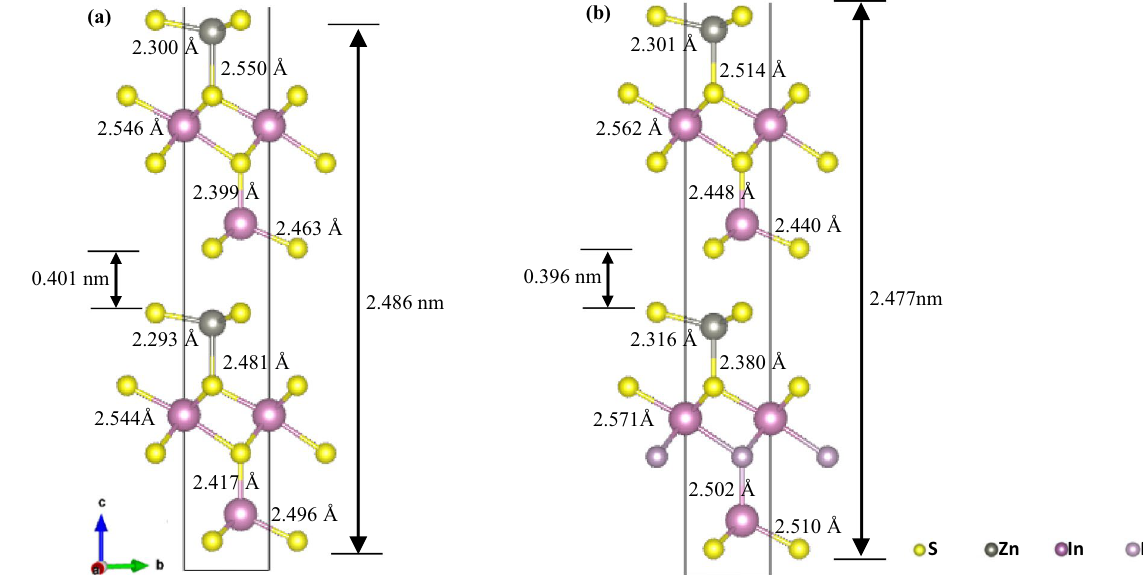
Figure 2. Simulated crystal structure for ( a ) pristine ZIS, and ( b ) P-ZIS (SPD-3).